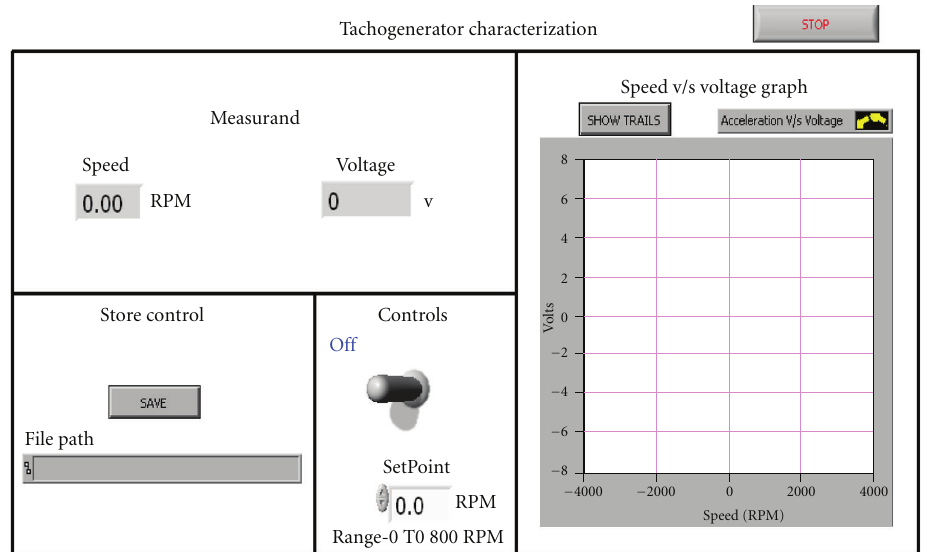
Figure 4: GUI for tachogenerator characterization experiment.